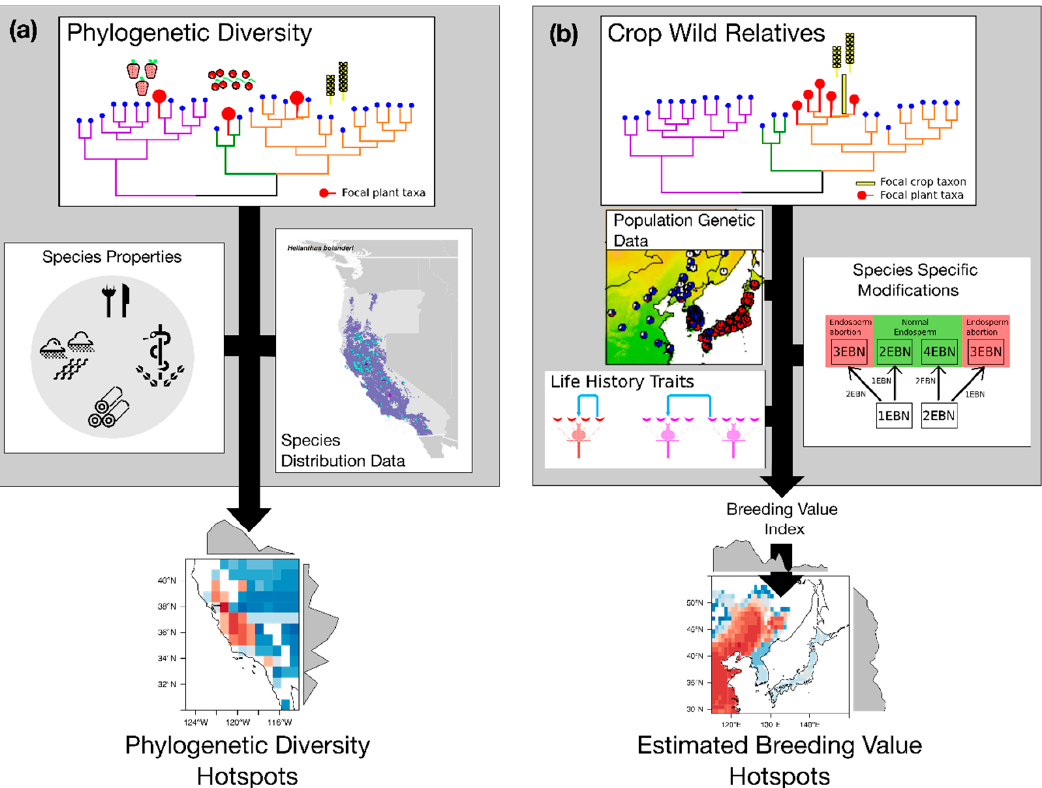
Figure 4. A proposed general framework for the further inclusion of genetic information into the mapping of agro-biodiversity hotspots. ( a ) A relationship between species evolutionary history and their physical or chemical properties (i.e., features or phenotype) would use phylogenetic diversity as a proxy for feature diversity, the latter being less readily quantifiable across wide ranges of species, regions and features. Combined with species distribution data, phylogenetic diversity could ultimately identifies hotspots of feature diversity and priority areas for the conservation of species’ contribution to people; ( b ) By considering phylogenetic information together with population genomics, cytology,